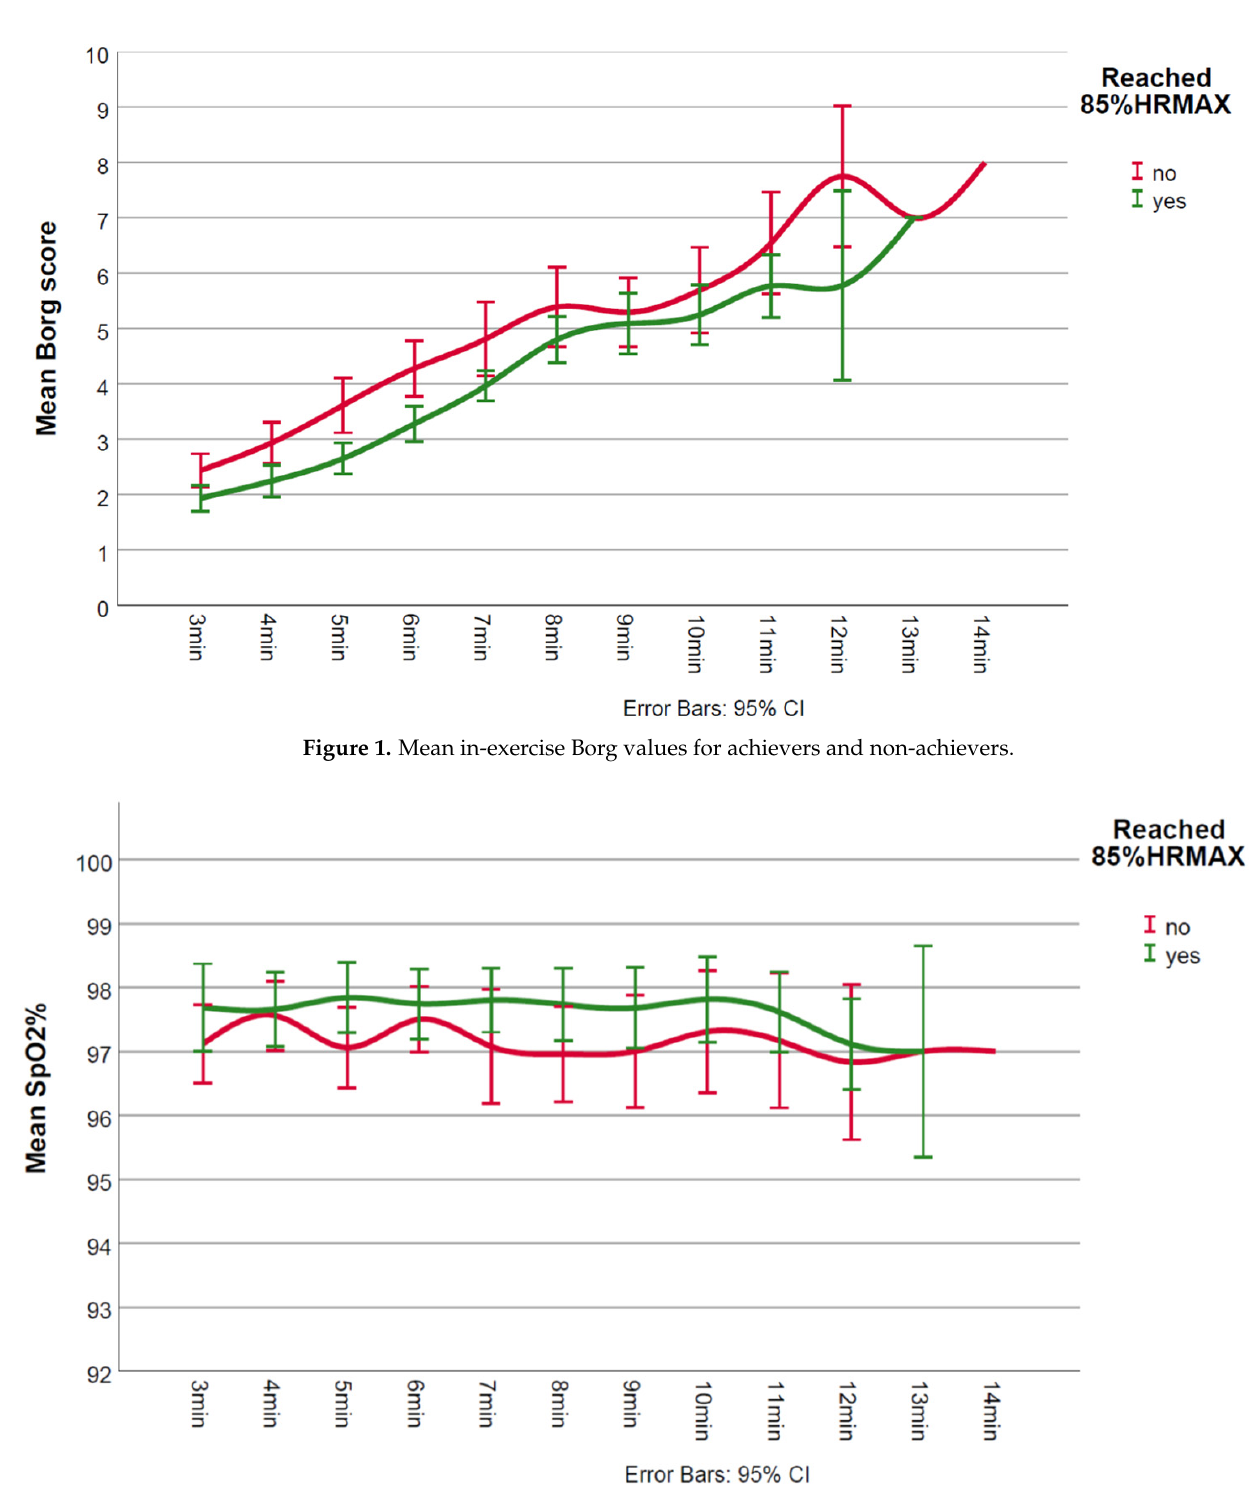
Figure 3. Mean revolutions per minute (rpm) values for achievers and non-achievers.